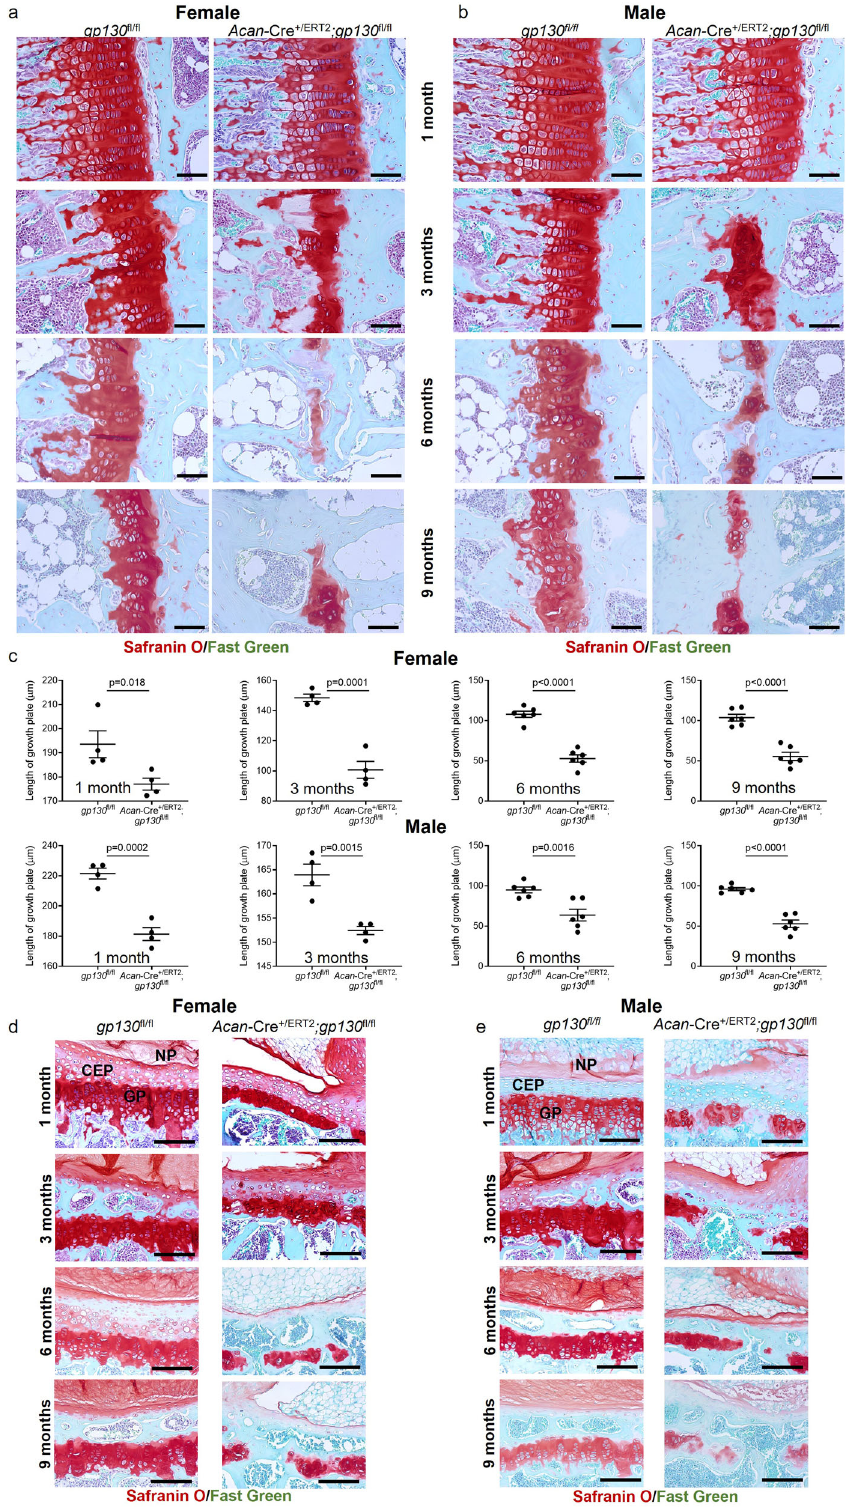
Fig. 7 Postnatal loss of gp130 in chondrocytes phenocopies Stat3 deletion. Proximal tibial growth plates were signi fi cantly reduced in thickness at all ages examined following deletion of gp130 at P2/P3 in female ( a , c ) and male ( b , c ) mice; severe growth plate disruptions were observed at 3 months. Vertebral body heights were reduced, coupled with loss of vertebral growth plates, in both female ( d ) and male ( e ) Acan -Cre + /ERT2 ; gp130 fl / fl mice as compared to gp130 fl / fl controls. AF annulus fi brosis, CEP cartilaginous endplate, NP nucleus pulposus. In all panels, scale bars = 50 µ m; n = 4 –